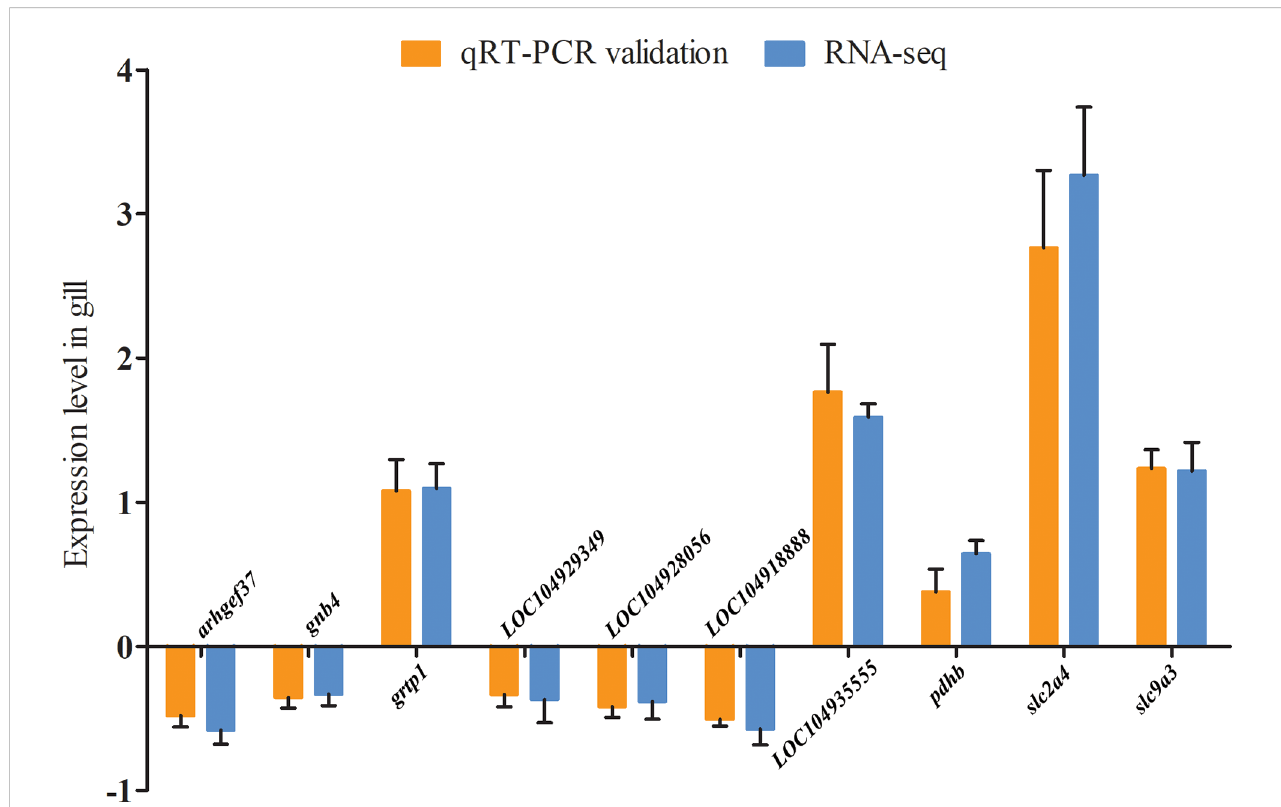
FIGURE 4 qRT-PCR validation of DEGs in the gills of large yellow croaker under low-salinity